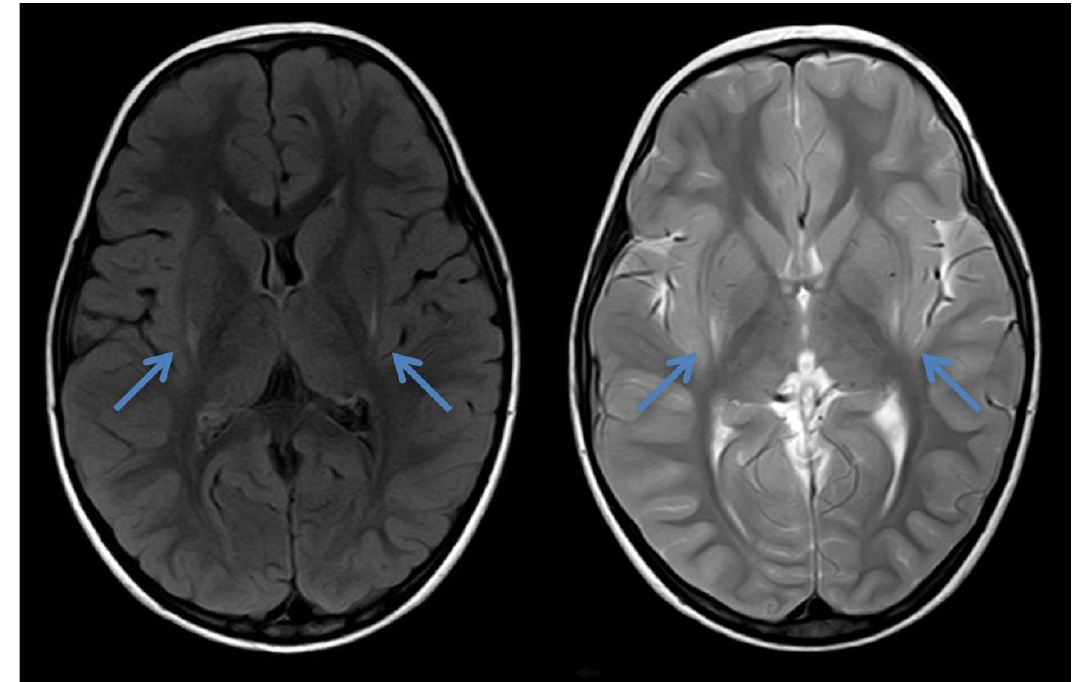
Figure 2. Cranial MRI of patient 2 at the age of 2 years and 8 months showing laterodorsal increased signal intensity bilaterally around the putamen (blue arrows) in axial FLAIR and T2—the typical insidious onset pattern of GA-1.